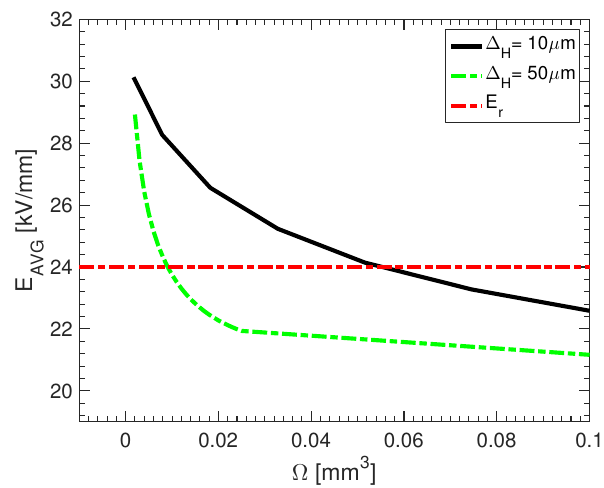
Figure 13: E AVG vs. Ω of two truncated-chamfer singu- larities having ∆ H = 10 µ m and ∆ H = 50 µ m. The respec- tive critical volumes differ from about a factor of 5, being the sharper singularity, i.e. ∆ H = 10 µ m, the one featuring the higher Ω C , hence the more critical. No dependence on L MAX is